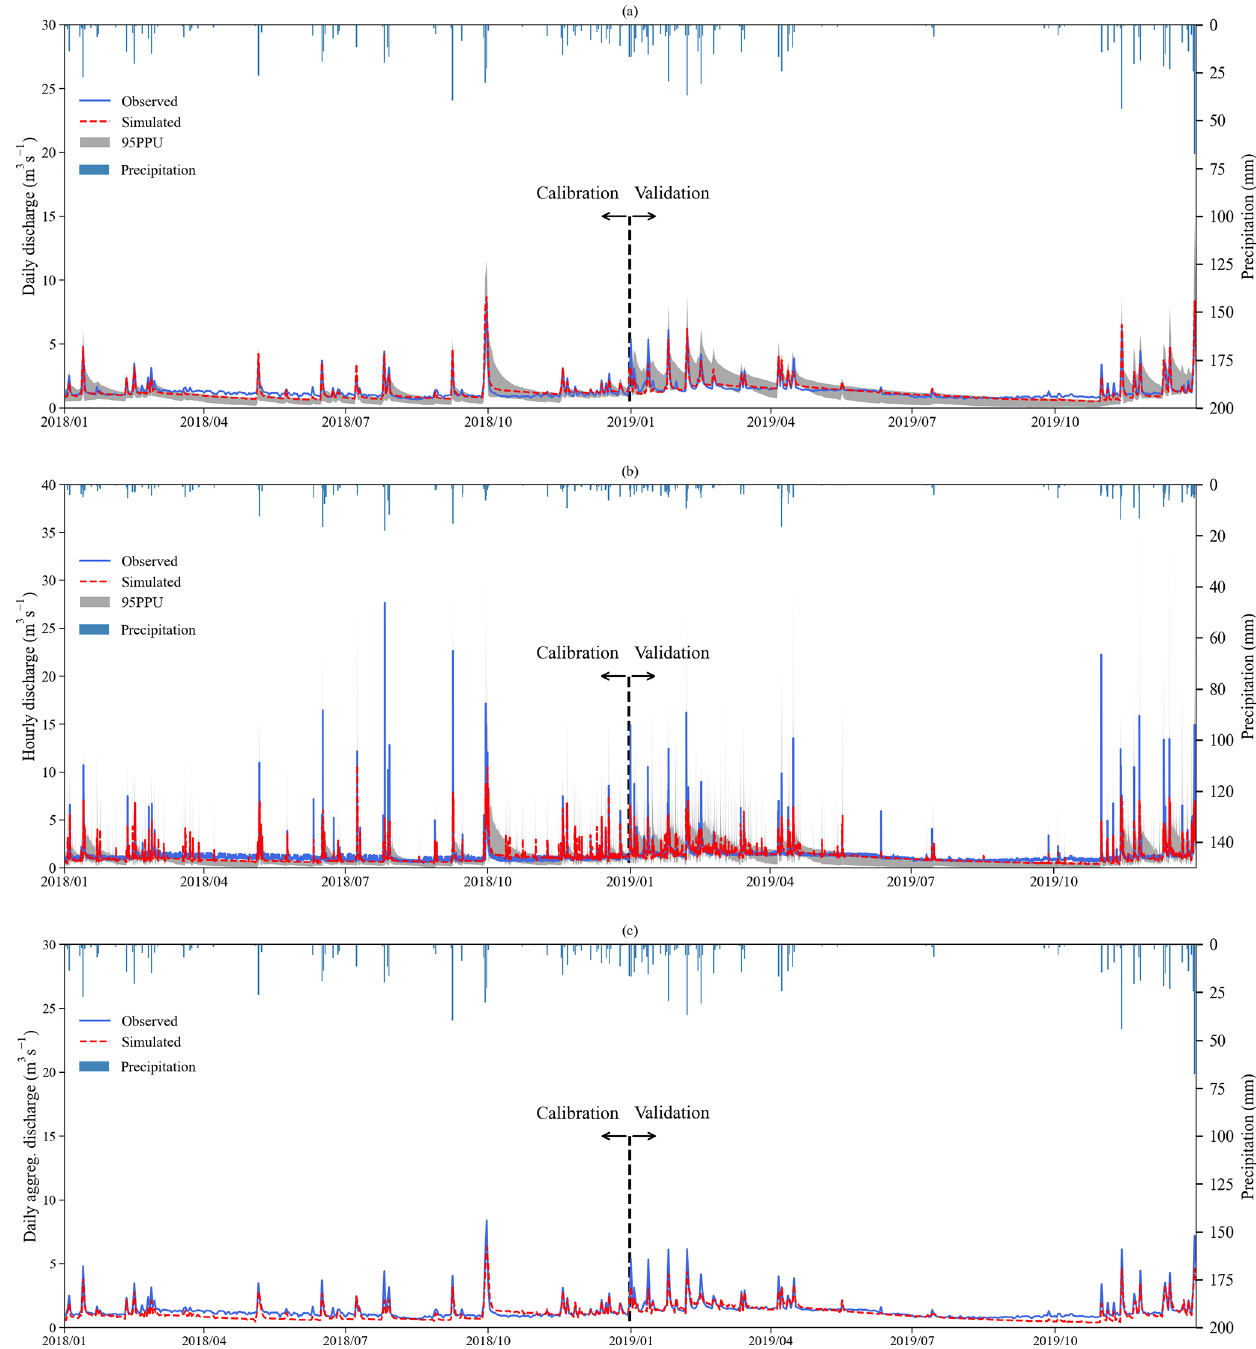
Figure 2. Observed and simulated discharge (m 3 s − 1 ) during calibration and validation periods. Daily time step (a) . Hourly time step (b) . Daily time step aggregated from hourly outputs (c) . The CN method, with daily rainfall observations, was used for the daily model, and the GAML method, with hourly rainfall observations, was used for the hourly